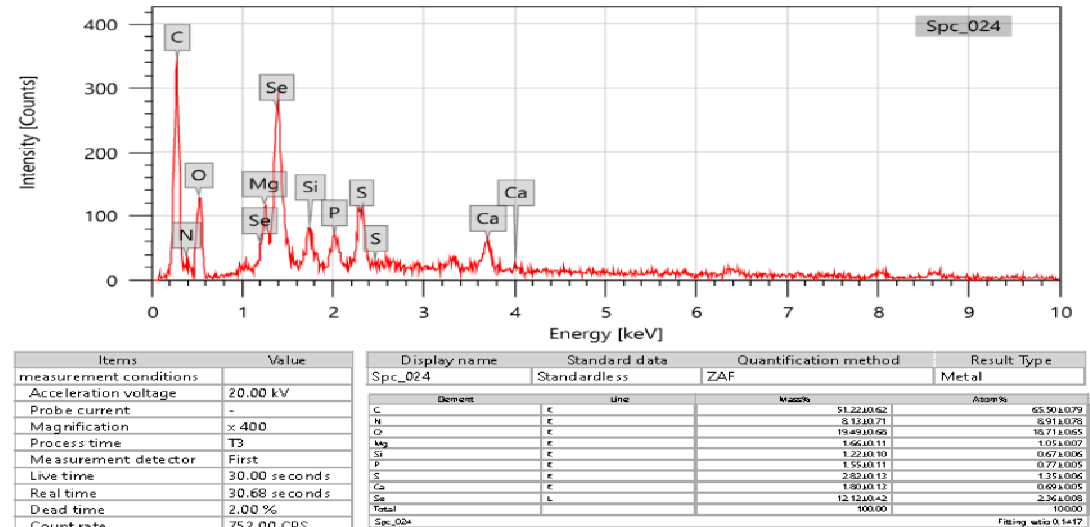
Figure 7. EDX analysis of USeNPs. Fig 7: EDX analysis of USeNPs 389